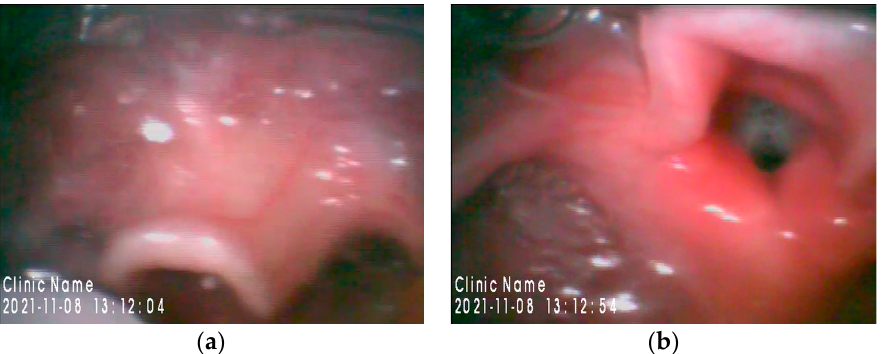
Figure 2. ( a ) Photograph of epiglottis on a Glidescope ® videolaryngoscope. ( b ) Laryngoscopic view of the